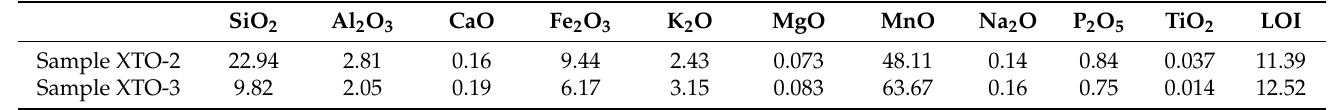
Figure 2. Representative hand specimens of the Mn-oxide ore in the Xiangtan deposit. ( a ) Reniform texture. ( b ) Massive-cellular texture; ( c ) oolitic and pisolitic texture; ( d ) botryoidal and conchoidal texture, the polished surface of location shown in ( a ) correspondingly; ( e ) massive texture; ( f ) lattice- earthy texture; ( g ) massive-vein texture; Qz—quartz; Crp—cryptomelane; Lim—limonite. Table 1. The contents of oxides (wt.%) and LOI (Loss on ignition) of powder samples from the Xiangtan deposit.